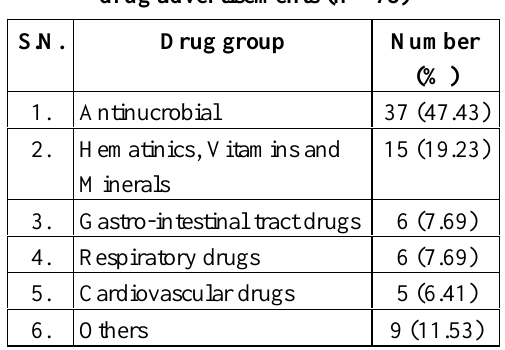
Table II : Group wise categorization of drug advertisements (n = 78) S.N.